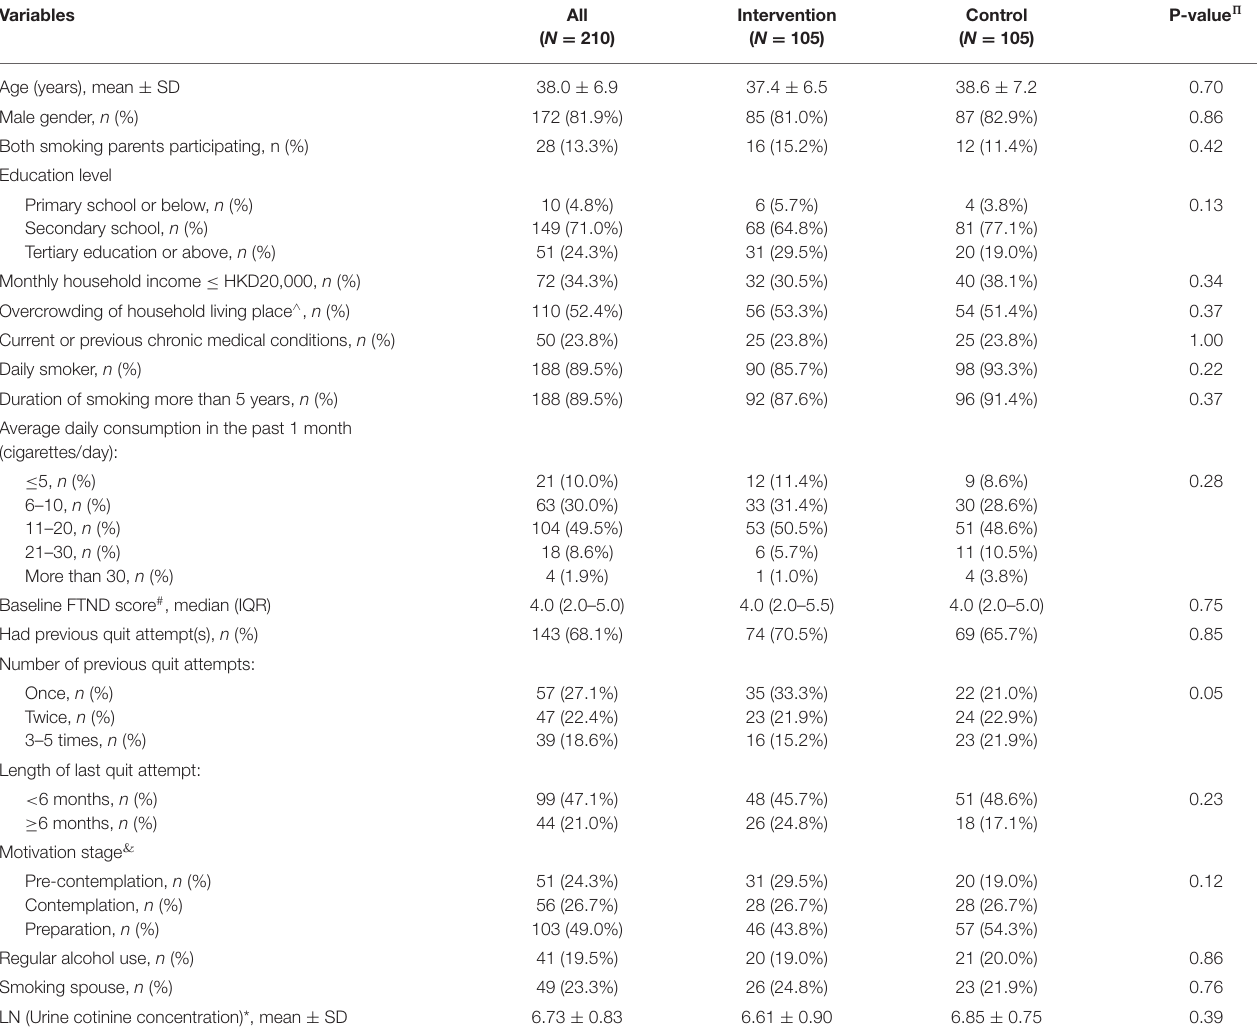
TABLE 1 | Baseline characteristics of the smoking parents ( N =